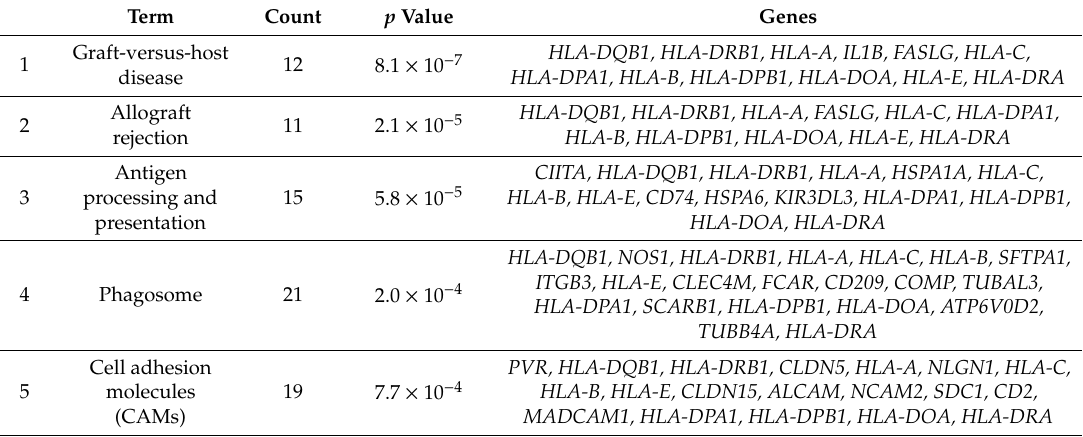
Table 2. GEPs (gene expression profiles) DAVID analysis of MDA-MB-231 xenograft mice exposed to 2 Gy of proton irradiation.